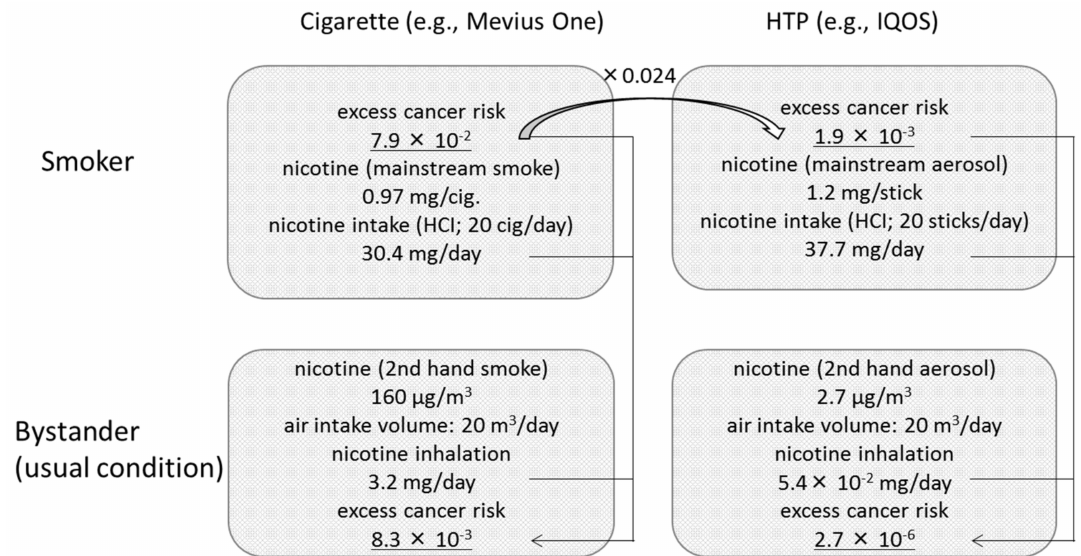
Figure 1. Process used to estimate excess cancer risk in bystanders exposed to cigarette smoke or heated tobacco product (HTP) aerosol under usual indoor conditions. Excess cancer risk was calculated using nicotine concentration results obtained by the Japanese Ministry of Health, Labour and Welfare, and unit risk calculated by Stephens